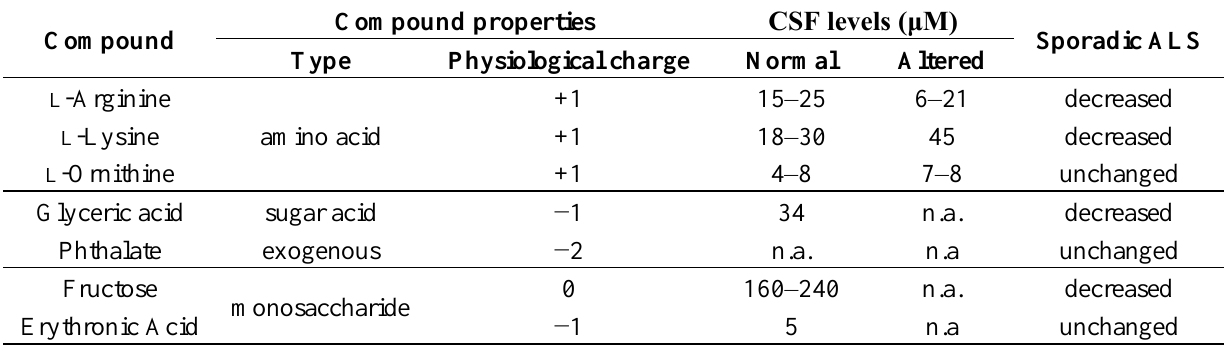
Table 1. Metabolites present in the cerebrospinal fluid (CSF)